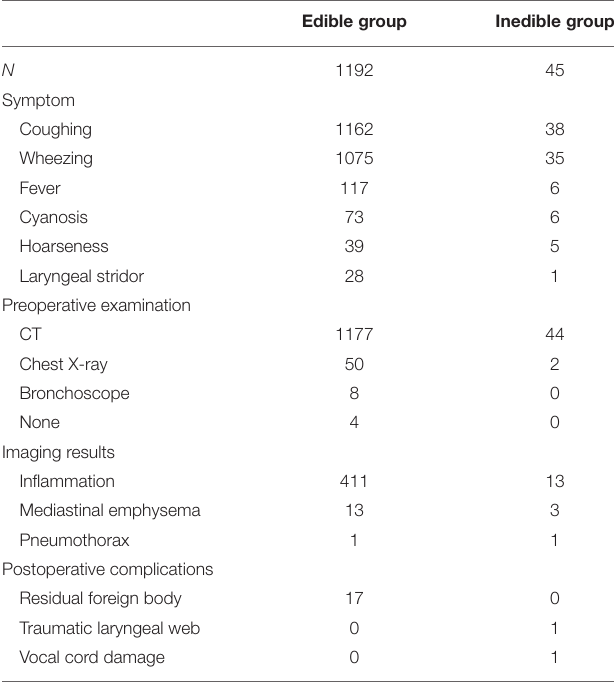
TABLE 3 | Location of foreign bodies in the airway between the edible foreign body group and the inedible group. Edible